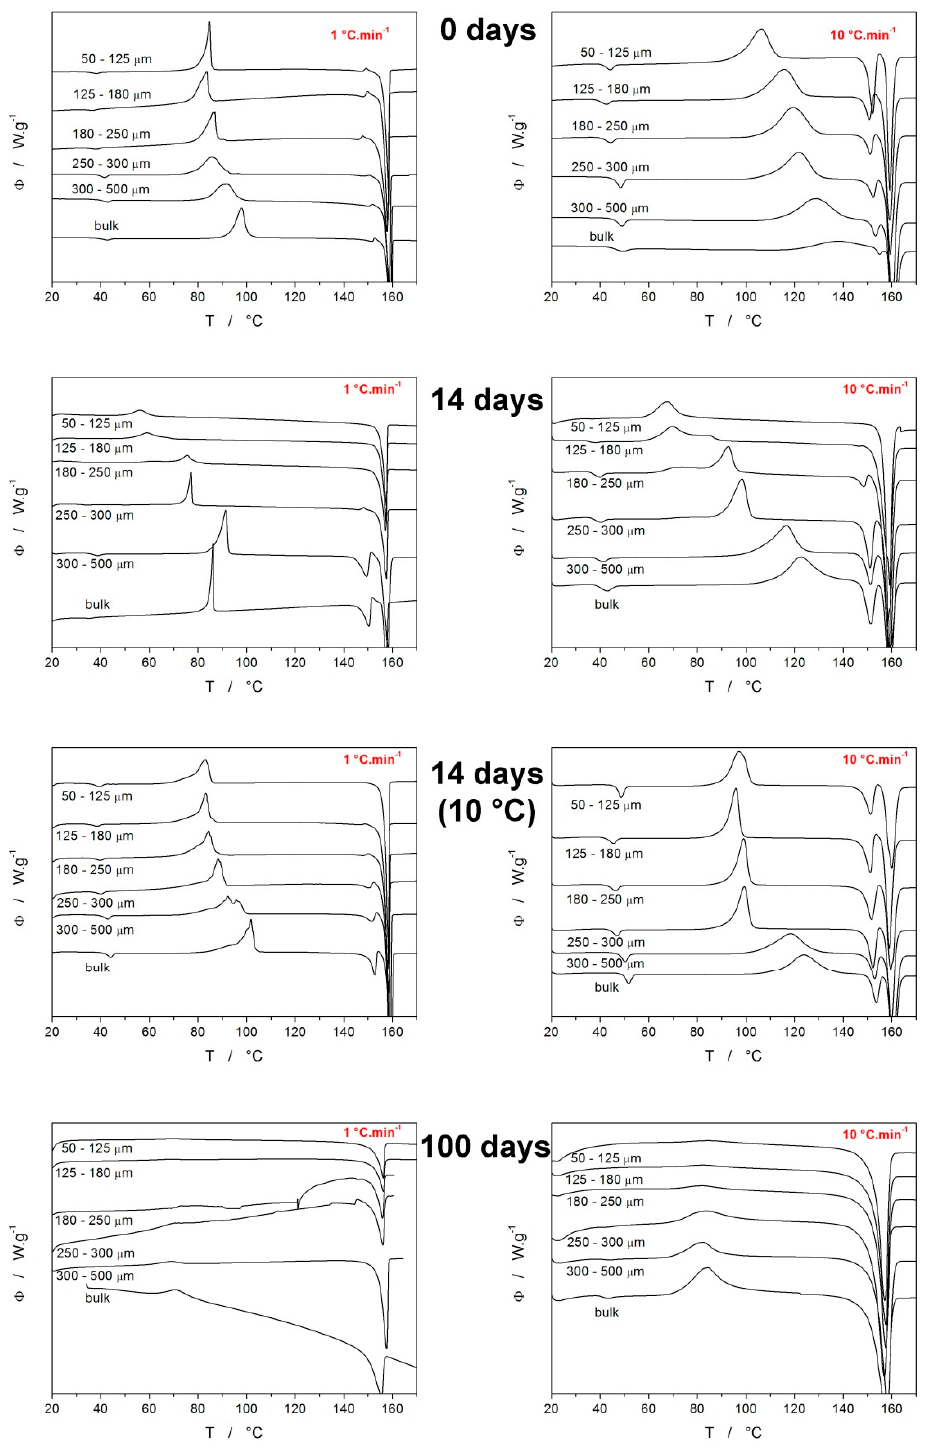
Figure 2. Example DSC curves obtained at 1 and 10 °C·min − 1 for various IMC powders with defined particle sizes. Each row of graphs corresponds to particular time and temperature storage conditions (powders were stored at laboratory temperature unless otherwise stated). Exothermic signals evolve in the upwards direction.